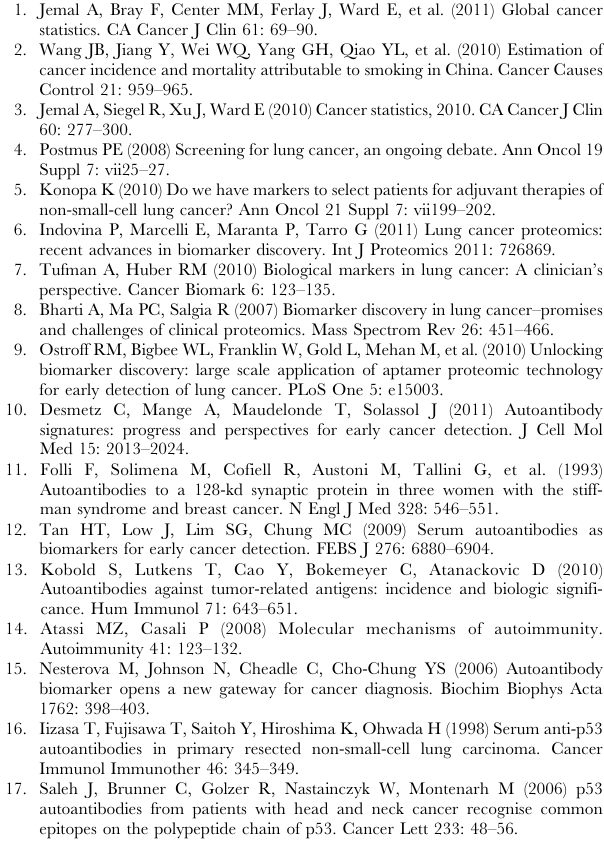
(TIF) Table S1 Association between APE1 protein expression and serum APE1-AAbs in 42 NSCLC patients. *was correlation coefficient. The correlation of serum APE1-AAbs levels between nucleus expression group and ectopic expression group (cytoplasm expresssion and nucleus/cytoplasm coexpres- sion) was statistically analyzed by Mann-Whitney. (DOCX) Table S2 Association between clinical characteristics and APE1 protein expression in NSCLC tissues. p values were calculated using chi-square test. Table S3 Association between serum APE1 antigen and serum APE1-AAbs in 137 NSCLC patients. *was correlation